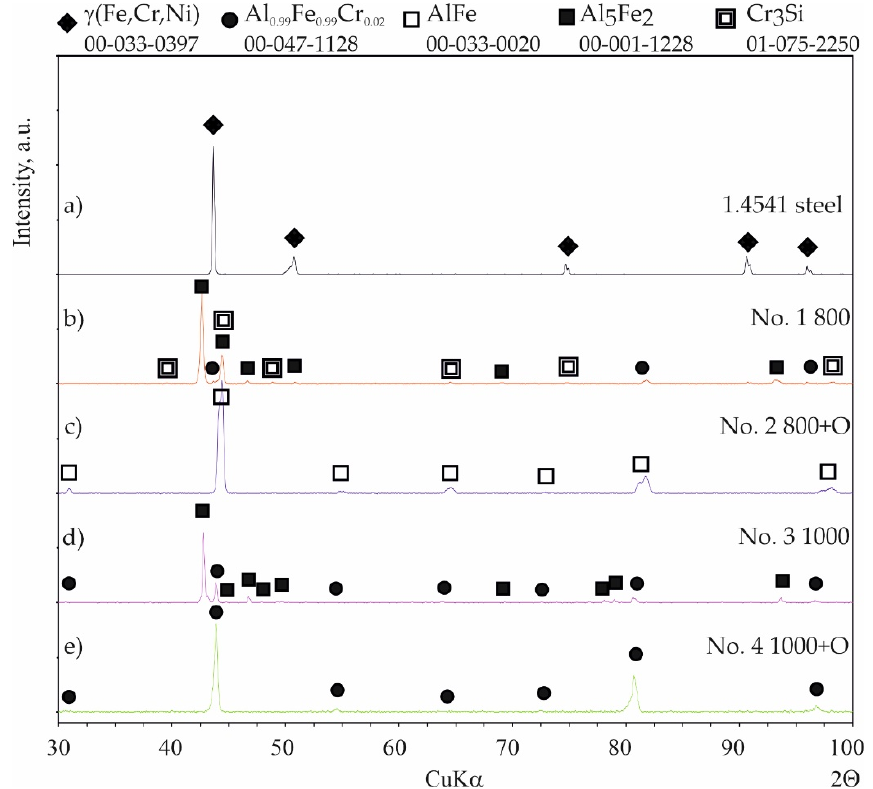
Figure 3. Diffraction patterns of 1.4541 steel: ( a ) uncoated; ( b ) with coating No. 1 (800 °C, 2 h); ( c ) with coating No. 2 (800 °C, 2 h + oxidation 1000 °C); ( d ) with coating No. 3 (1000 °C, 2 h); ( e ) with coating No. 4 (1000 °C, 2 h + oxidation 1000 °C). Table 2. The results of the EDS point analysis of the coating according to Figure 2. Chemical Composition, at.% Al Point of Analysis Probable Phase